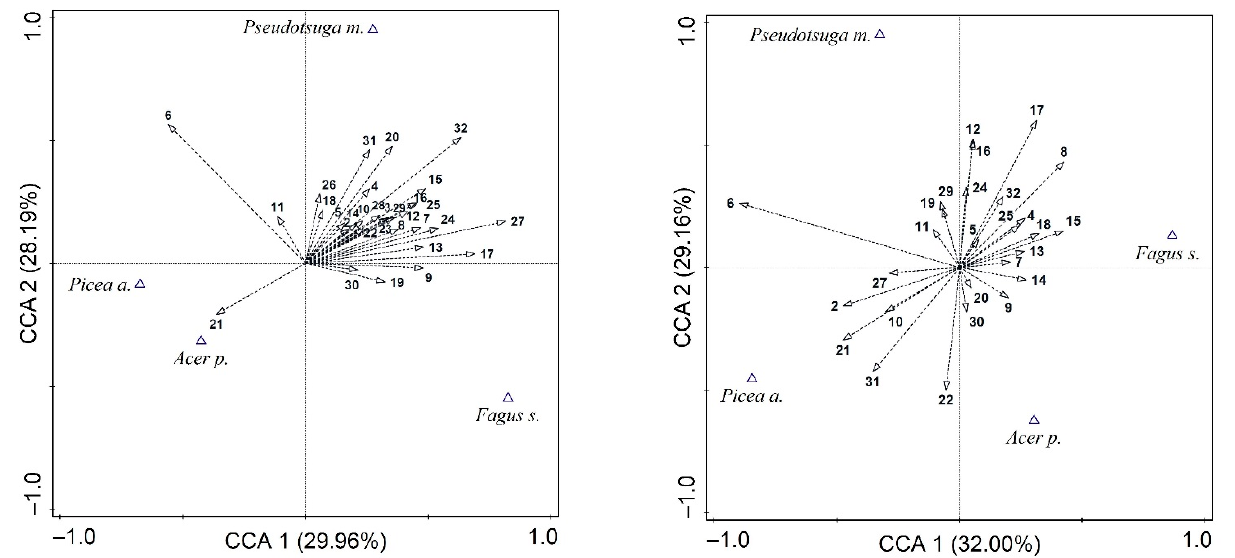
Figure 3. Canonical correspondence analysis based on community-level physiological profiles in different forest stands in O-horizon (left) and A-horizon (right). Arrows represent the direction of the steepest increase of activity within individual functional groups. Triangles represent individual